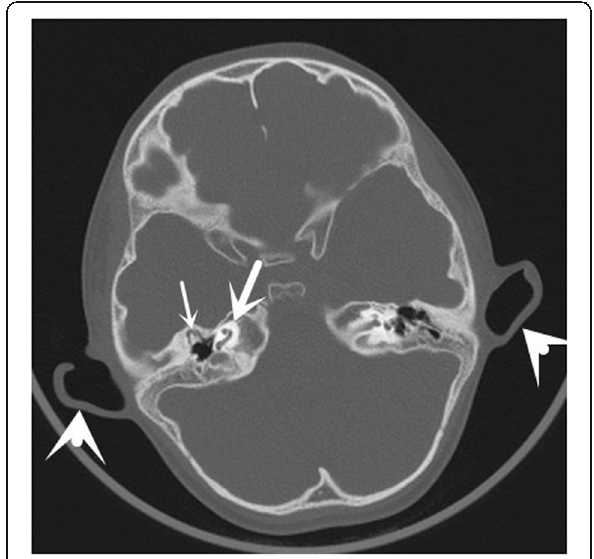
Fig. 3 Axial computed tomographic images of the temporal bone from subject III:5. The small arrow indicates a malformed middle ear, including anteriorly displaced abnormal ossicles and hypoplastic mastoid cells. The middle arrow indicates malformed cochlea. The large arrow indicates